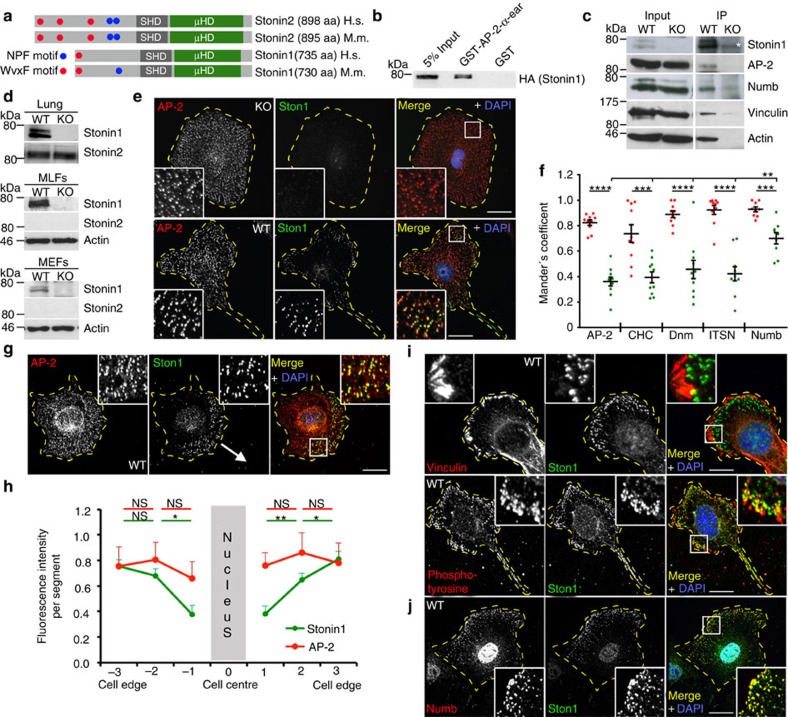
Stonin1 is an endocytic adaptor localizing close to FAs.(a) Stonin1 and Stonin2 domain structure. SHD, Stonin homology domain; μHD, μ-homology domain. H.s., Homo sapiens; M.m., Mus musculus. (b) Stonin1 interacts with AP-2. Bead-coupled GST-AP-2α-ear resp. GST as control was incubated with lysate from cells overexpressing Stonin1-haemagglutinin (HA). Bound proteins were eluted from washed beads and analysed by immunoblotting with HA-specific antibodies. (c) Stonin1 associates with endocytic and FA proteins. Bead-coupled Stonin1-specific antibodies were incubated with WT and Stonin1−/− lung lysate. Bound proteins were eluted from washed beads and analysed by immunoblotting with the indicated antibodies (* indicates an unspecific band). (d) Stonin1 and Stonin2 protein expression in different tissue and cell types. Lysates from WT and Stonin1−/− cells were analysed by immunoblotting using antibodies specific for Stonin1, Stonin2 and actin. MLFs, mouse lung fibroblasts; MEFs, mouse embryonic fibroblasts. (e–j) Stonin1 co-localizes with endocytic proteins at peripheral CCPs close to FAs. (e,g,i,j) Fixed WT and Stonin1−/− MEFs were stained with antibodies specific for the indicated proteins and analysed by confocal microscopy. Insets show enlargements of boxed areas. DAPI-stained nuclei are depicted in blue. Scale bar, 25 μm. (f) Quantification of co-localization from images such as in e using Mander's coefficients. Red: correlation of Stonin1 with endocytic proteins; green: reverse correlation (data are depicted as mean±s.e.m., n=9–10, unpaired two-tailed Student's t-test for comparisons between two types of correlations for the same staining, one-way analysis of variance followed by Dunnett post-test to compare Mander's coefficients for correlation of Numb with Stonin1 with Mander's coefficients for correlations of other endocytic proteins with Stonin1, ****P<0.0001, ***P<0.001, **P<0.01). Only the outer 2/3 of cell area were evaluated to exclude unspecific nuclear background staining. (h) Comparison of Stonin1 and AP-2 distribution across the cell based on clock scans on images such as in e (data are depicted as mean±s.e.m., n=14, unpaired two-tailed Student's t-test, **P<0.01, *P<0.05). DAPI, 4,6-diamidino-2-phenylindole; NS, not significant.